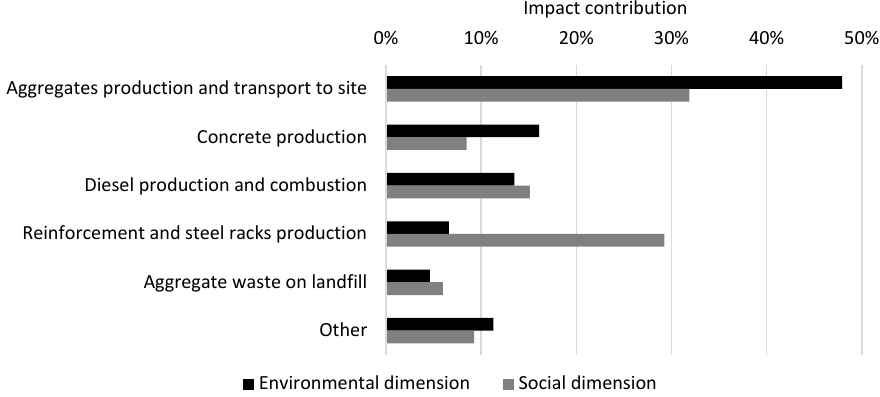
Figure 3. Contribution of resources to the total impact over the life cycle (modules A–C, excluding B8) for the CSF bridge design concept in the environmental and social